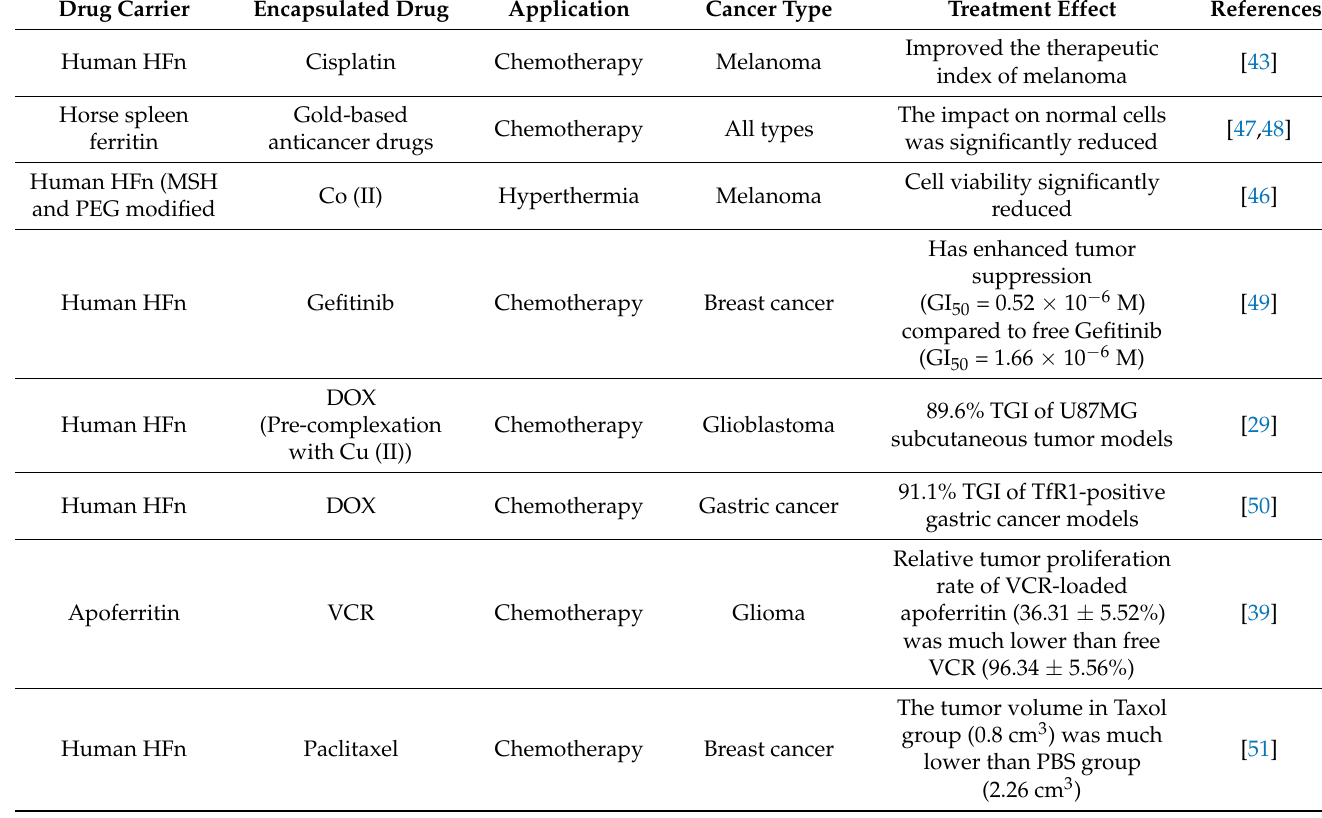
Table 2. Drug loading of